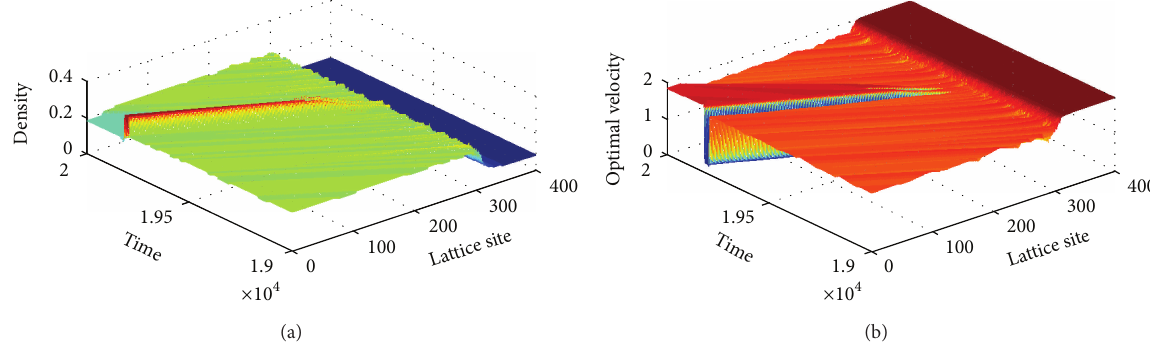
Figure 5: The spatiotemporal evolutions of MLC for 𝜌 ℎ = 0.05 , 𝑄 on = 0.1 .